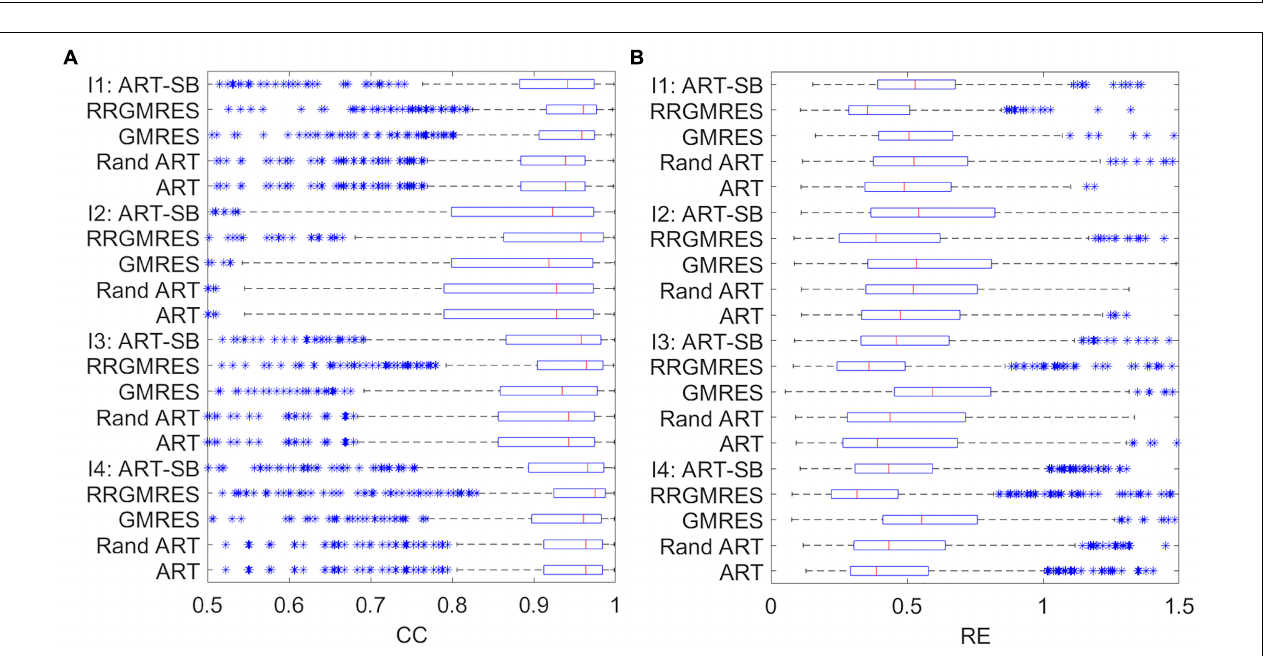
FIGURE 4 | Boxplots showing the mean, the distribution, the standard deviation (“whiskers”) and the outliers (“*”), for: (A) CC and (B) RE. The y -axis show the reconstruction method used for each one of the two control recordings of the Utah dataset (Control 1, Control 2).